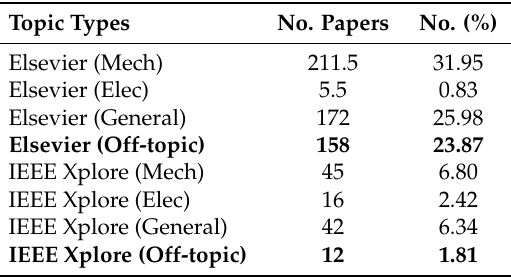
Table 2. Details on paper thematic distribution.